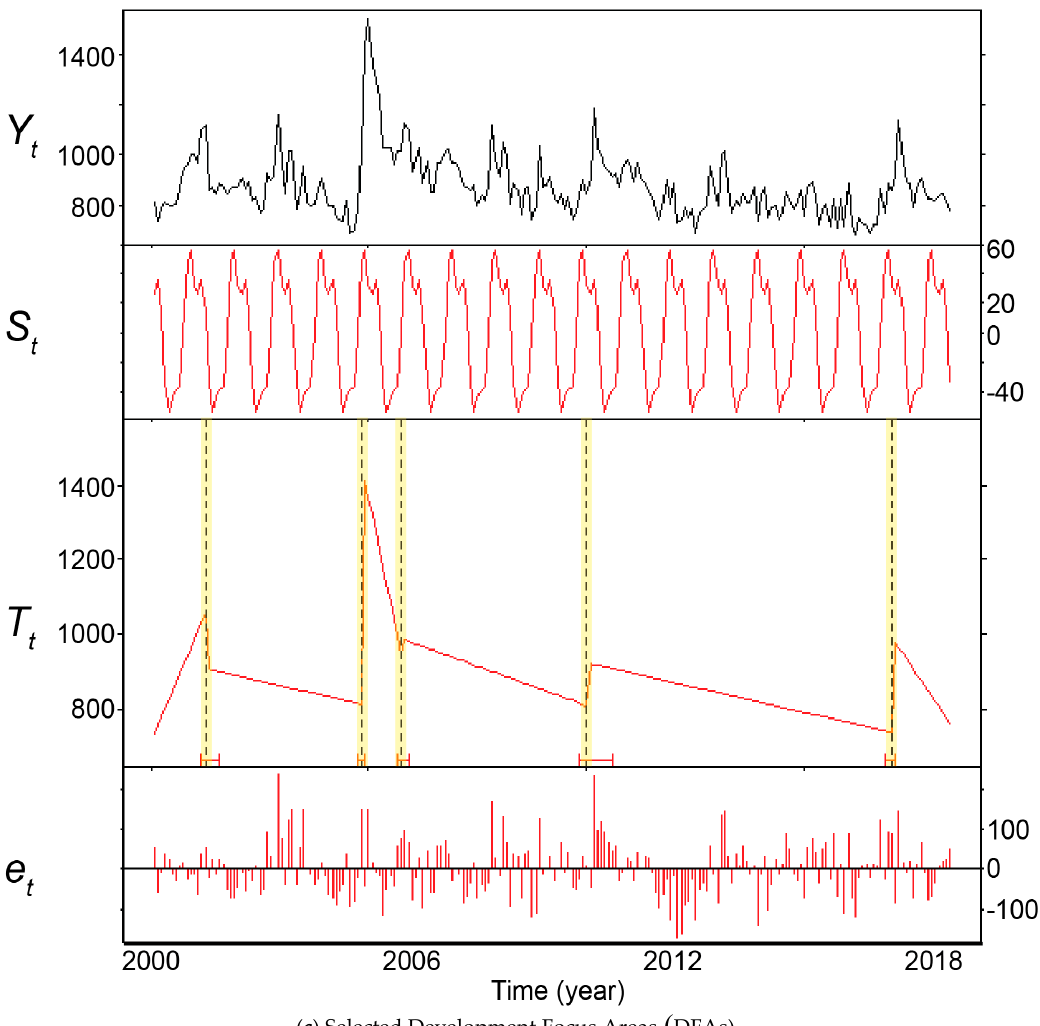
Figure 3. Sample BFAST NDVI results for the three main study areas, February 2000 to May 2018. The MODIS time series NDVI ( Y t ) was decomposed into seasonal ( S t ), trend ( T t ), and remainder ( e t ) components. The seasonal component is estimated by taking the mean of all seasonal subseries (e.g., for a monthly time series the first subseries contains the January values). Breakpoints are indicated by dashed vertical lines and yellow highlights. Vertical axis units are NDVI × 10,000.